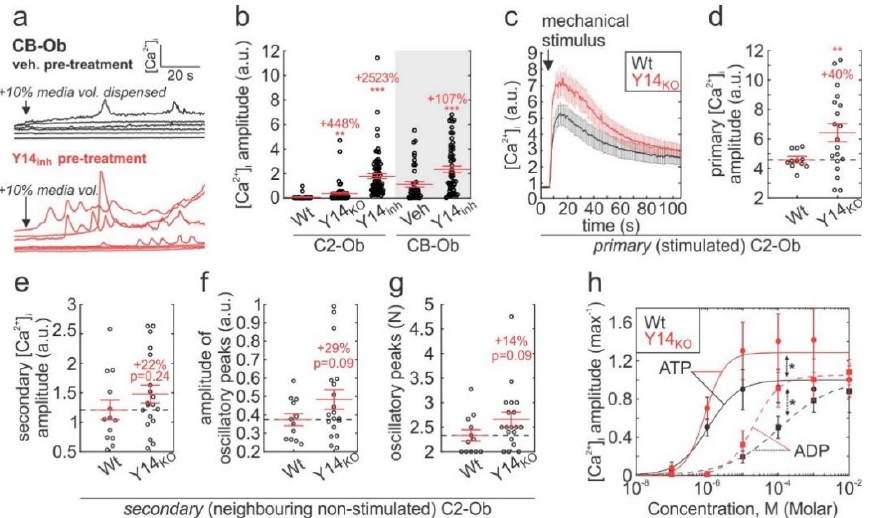
Figure 3. P2Y 14 involvement in tuning mechanical- and purinergic-signalling in osteoblasts. ( a , b ) Fura2-loaded CB-Ob and C2-Ob (Wt or Y14 KO ) cells were pretreated with vehicle (0.1% DMSO) or 100 nM PPTN (Y14 inh ) for 10 min, and then mechanically-stimulated by dispensing 10% media volume into culture; ( a ) Representative [Ca 2 + ] i recordings in stimulated CB-Ob; ( b ) [Ca 2 + ] i elevation amplitudes. Raw data and means ± sem are shown, n = 4–5 independent cultures, 9–20 cells recorded per culture. ( c – g ) Individual Fura2-loaded Wt or Y14 KO C2-Obs were mechanically-stimulated by micropipette. ( c ) [Ca 2 + ] i responses and ( d ) amplitudes of [Ca 2 + ] i responses in the primary (stimulated) cell. Data are means ± sem, n = 14–20 independently stimulated cells (i.e., trials). ( e – g ) [Ca 2 + ] i responses in secondary (neighbouring non-stimulated) cells were analyzed for their amplitude ( e ), and amplitude ( f ) and number ( g ) of oscillatory peaks. Raw data and means ± sem are shown, n = 14–20 trials with 8–23 cells recorded per trial. ( h ) Fura2-loaded Wt and Y14 KO C2-Obs were stimulated with ATP or ADP, and [Ca 2 + ] i elevation amplitudes were determined. Solid and dashed curves are the Hill functions that fit the ATP and ADP data, respectively. Data are means ± sem, n = 3 independent cultures, 8–23 cells recorded per culture. For ( b – g) , ** p < 0.01 and *** p < 0.001 significance assessed by ANOVA and post-hoc Bonferroni test (versus Wt or Veh conditions); for h, * p < 0.05 significance determined by 2-way ANOVA.